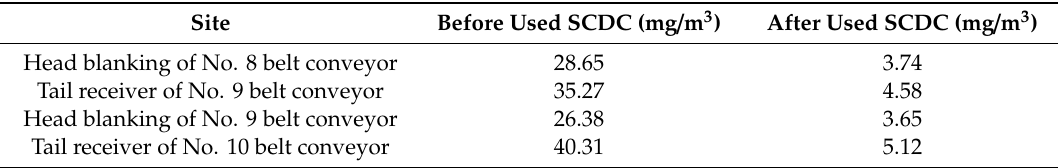
Table 3. Dust concentration in number 4 and number 5 transfer